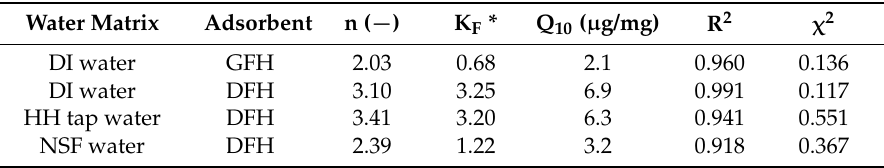
Table 3. Parameters of the Freundlich isotherm for As(V), along with the correlation coefficients and the respective chi-squared